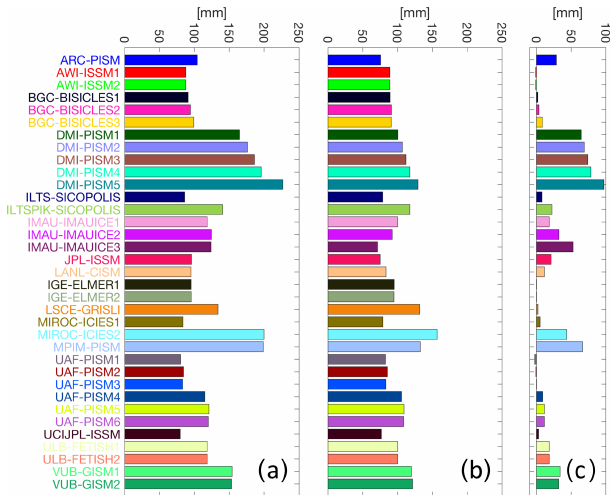
Figure 12. Sea-level contribution in 2100 derived by integrating a transient aSMB over the initial ice mask of each initMIP-Greenland model (a) without remapping but with extension to the modelled ice sheet extent and (b) with remapping to the initial surface elevation of each individual model. The differences between (a) and (b) are shown in (c)